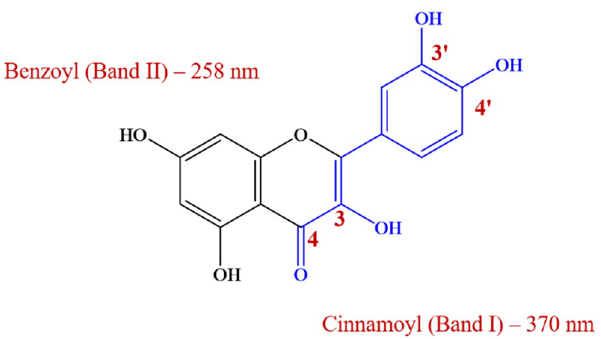
Figure 1. Quercetin structure and assignment of characteristic absorption maxima to specific structural features.